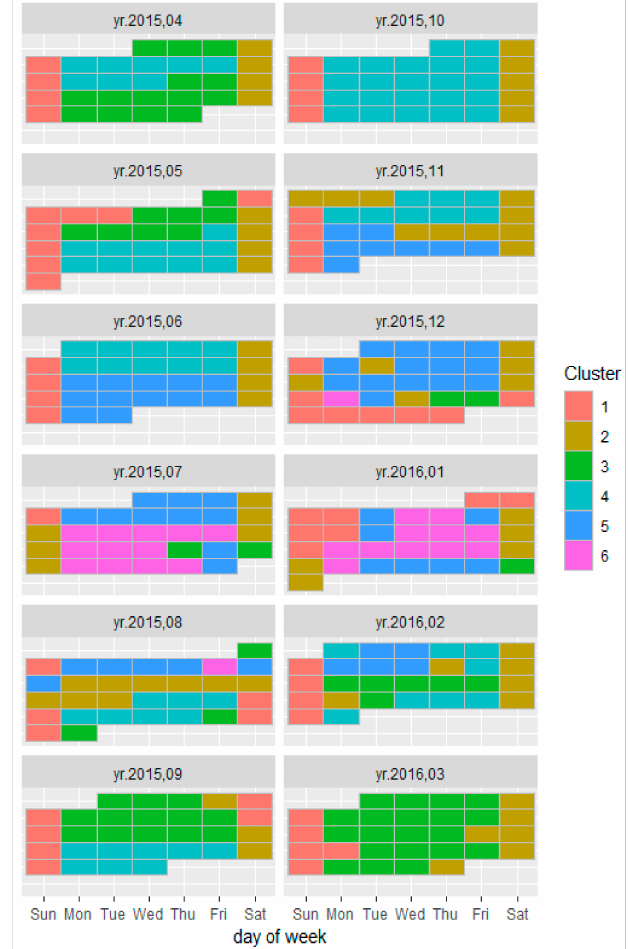
Figure 11. Actual calendar plot of Chubu University.